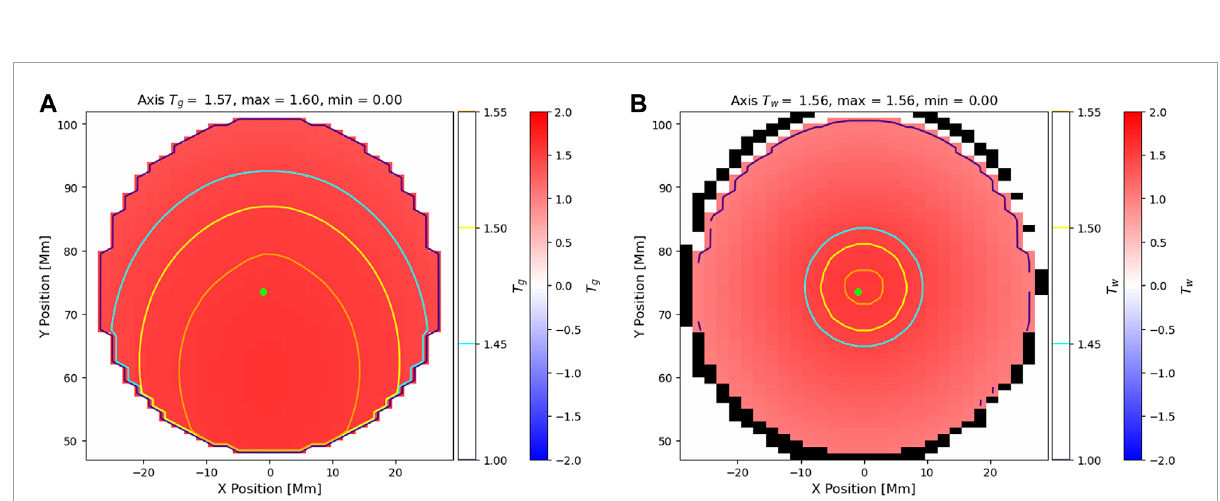
FIGURE 3 Output from the visualisation notebook showing the T g (A) and T w (B) planes with their corresponding contours overlaid. A lime dot indicates the centre chosen in Figure 1 . The dot is slightly displaced due to the difference in resolution.